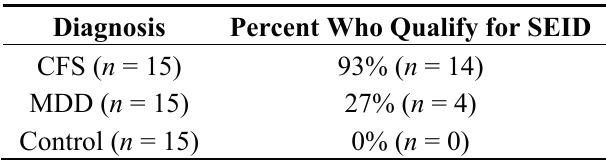
Table 2. CFS vs. MDD Database n =